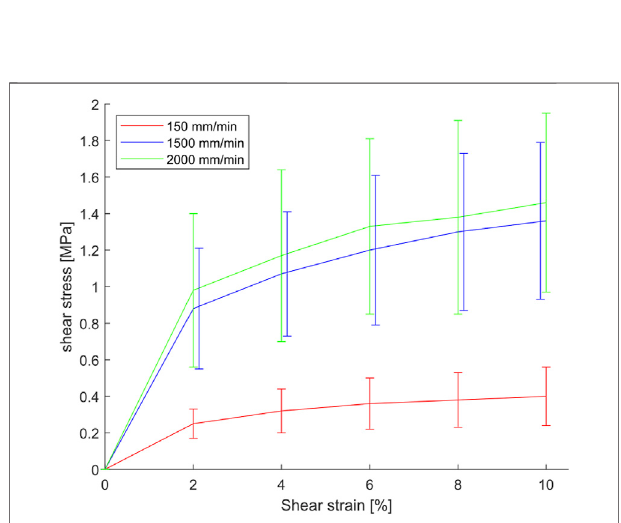
FIGURE9| Rate-dependentshearstressF02Dstraincurvesofuncured HexPly ® M79/34%/UD300/CHS prepreg.